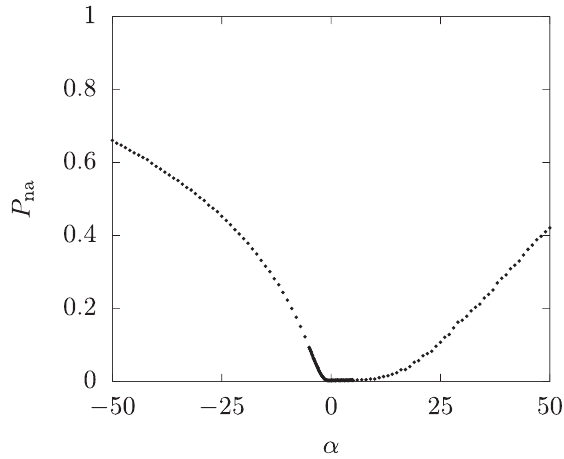
− J ) for particles at b a ; i FIG. 9. P as a function of the detuning coefficient α . The map na (61) has been used with parameters q ¼ − 0 . 008 , ω ω 2 . 602 , ω 2 . 5 , ω 2 . 7 , 2 . 5 , ω 2 . 7 , N ¼ 10 5 , and a set of initial conditions x ¼ y ; i ¼ y ; f ¼ y ; i ¼ y ; f ¼ 10 − 4 , h I 4 × 10 − 4 with h I x ; i i ¼ y ; i i ¼